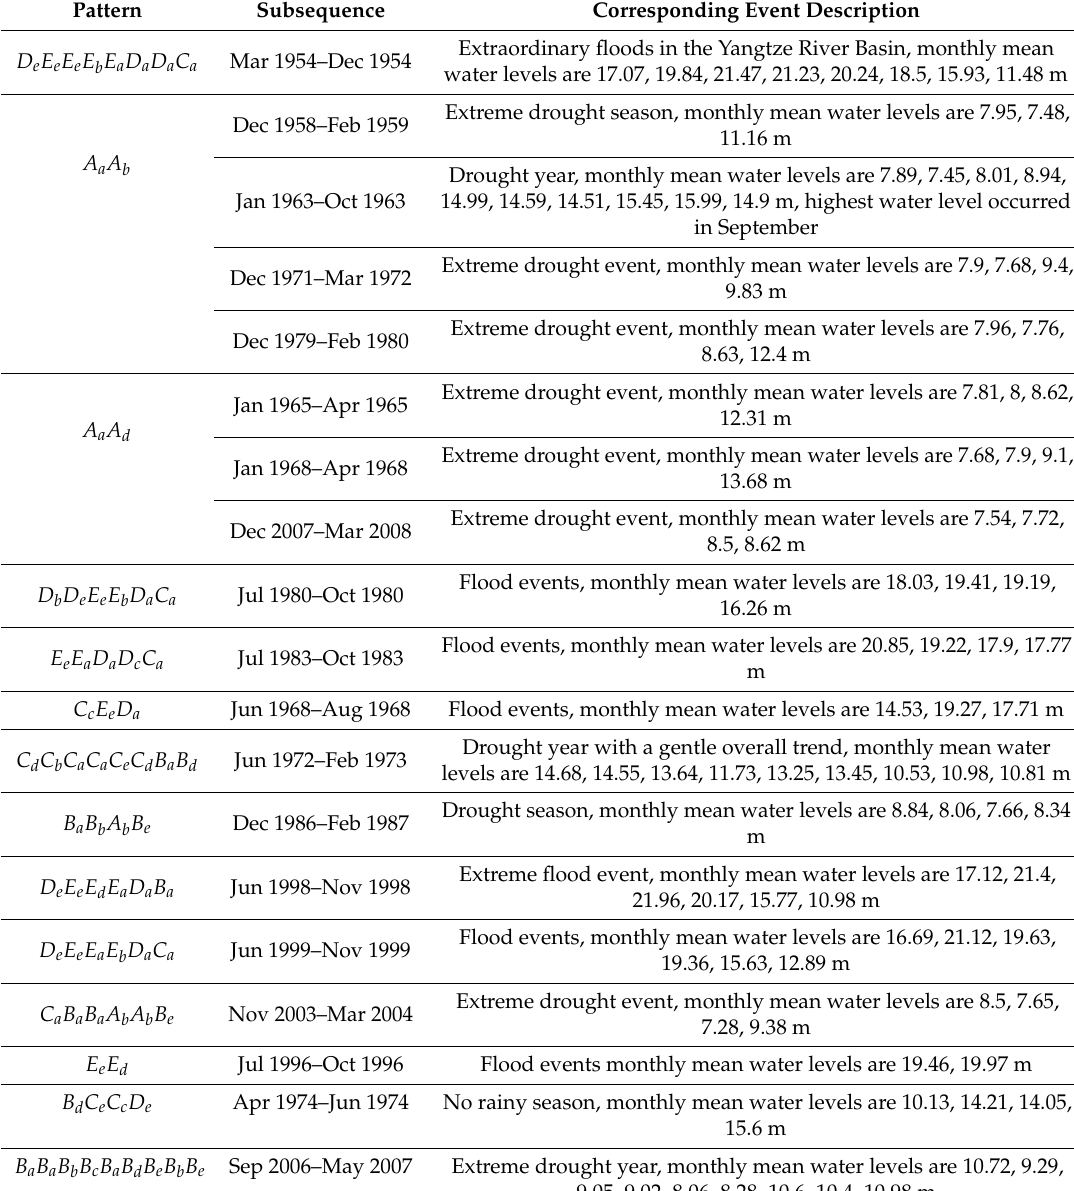
Table 8. Anomalous patterns detected by the algorithm and event descriptions at the Xingzi station.